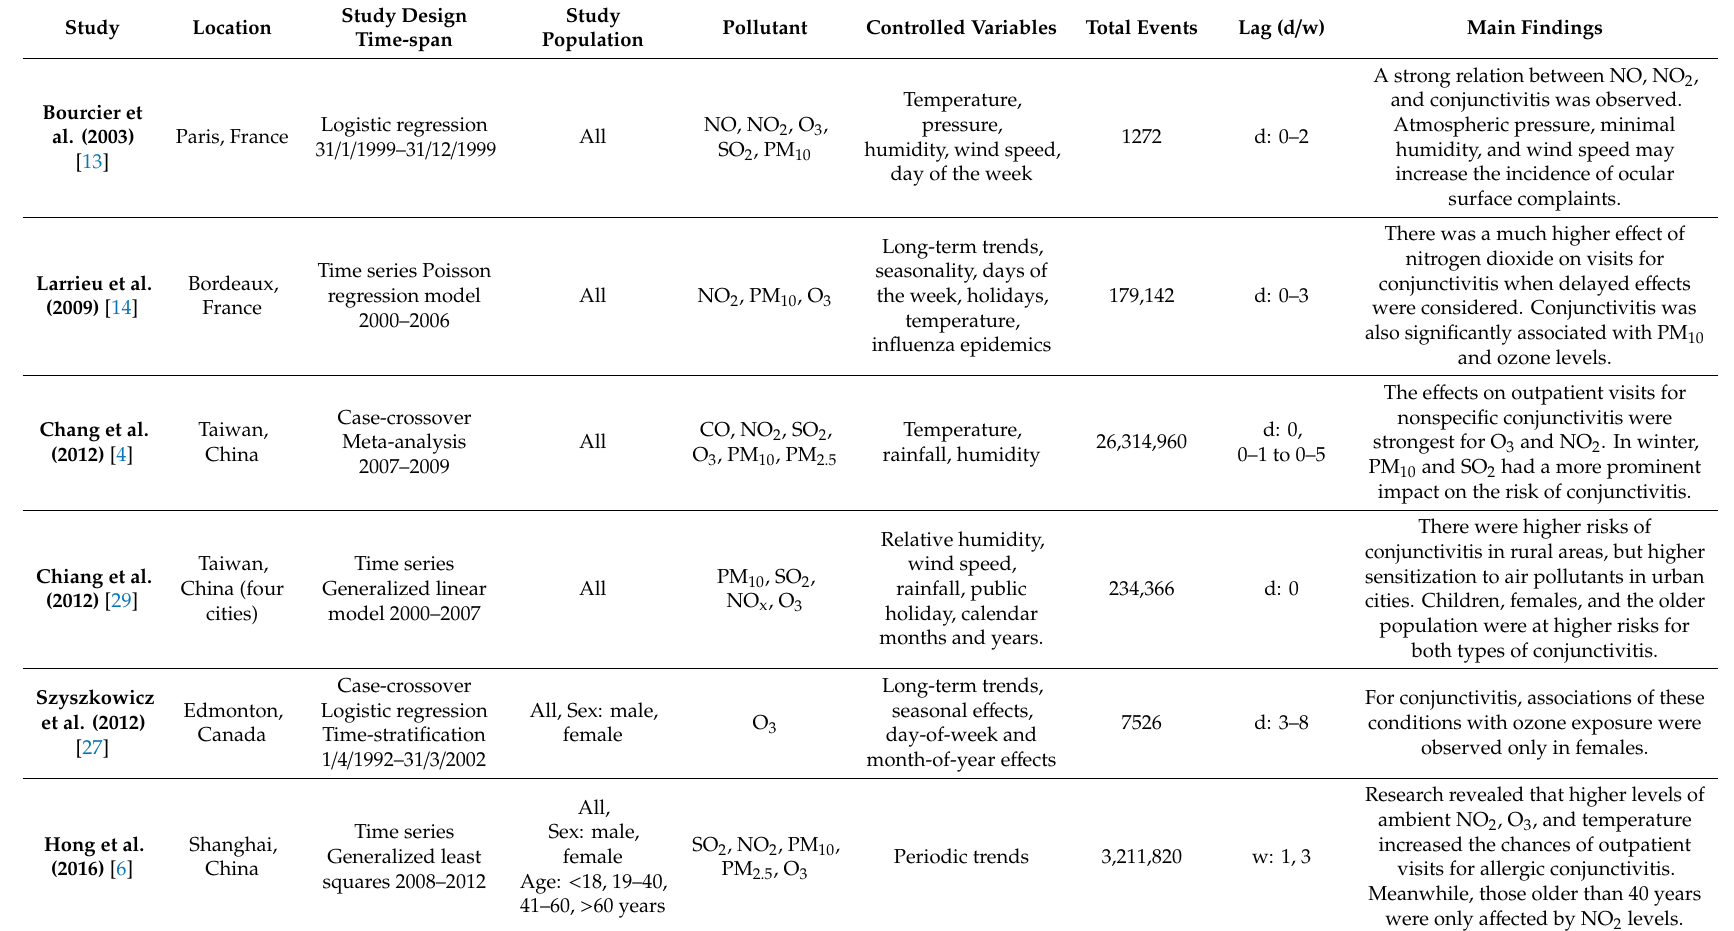
Table 1. The characteristics of studies included in the